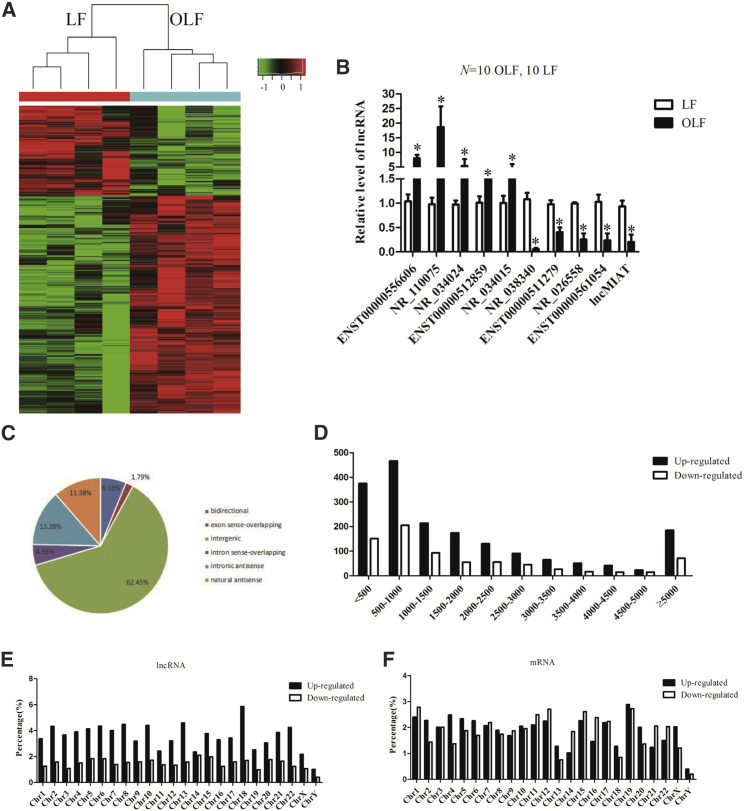
The Differentially Expressed lncRNAs in OLF(A) Microarray analysis for lncRNAs was performed with RNA extracted from ossification (n = 4) and normal (n = 4) ligamentum flavum. Hierarchical cluster analysis of significantly differentially expressed lncRNAs: bright green, under-expression; gray, no change; bright red, overexpression. (B) Differential expression of ten representative lncRNAs was validated in human ossified and normal ligamentum flavum tissues by qPCR (n = 10 per group). GAPDH was used as an internal control. (C) The deregulated lncRNAs were divided into intergenic, antisense, natural antisense, bidirectional, intron sense-overlapping, and exon sense-overlapping. (D) The deregulated lncRNAs were classified according to different lengths. (E and F) The deregulated lncRNAs (E) and mRNAs (F) were classified according to their percentages in different chromosomes. Data are presented as mean ± SEM; p values were analyzed by Student’s t test; *p < 0.05.